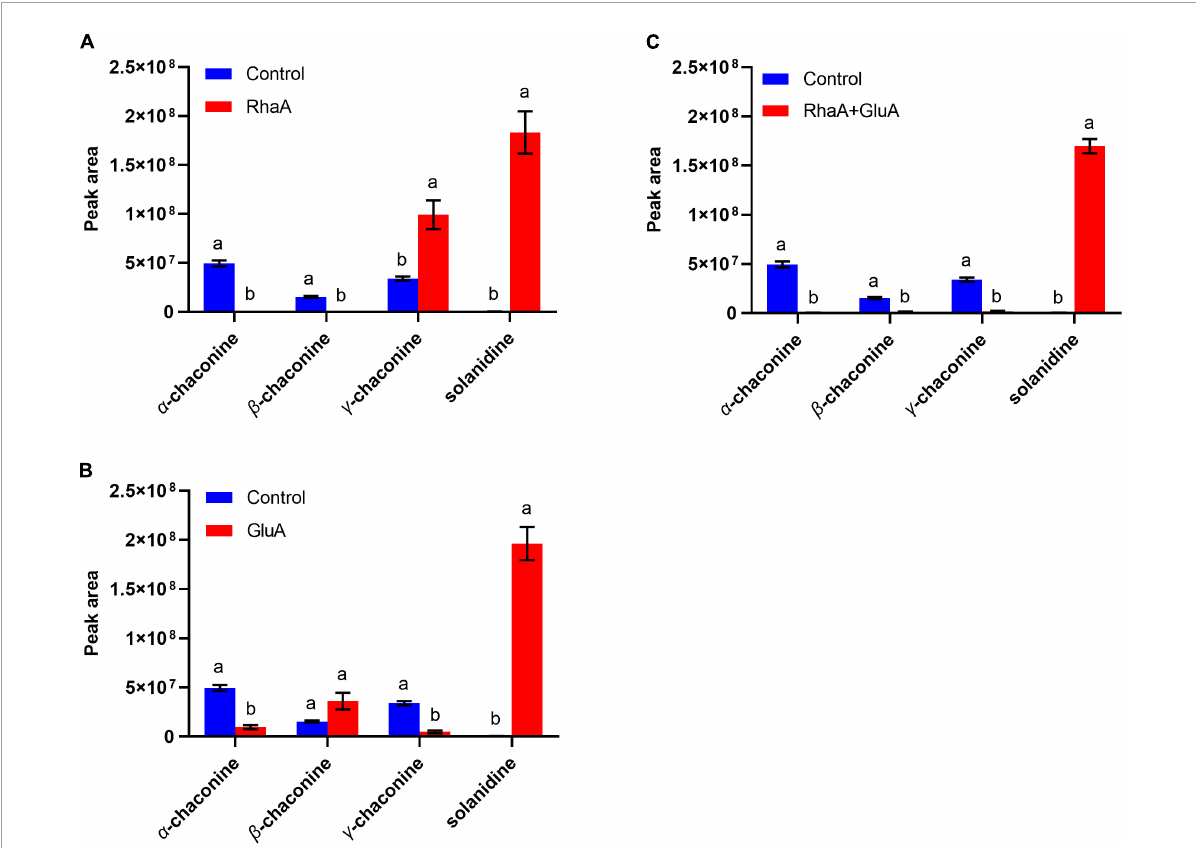
FIGURE4 Hydrolysis products released from α -chaconine standards by the action of recombinant enzymes of (A) RhaA; (B) GluA; (C) RhaA + GluA. Bars (mean ± SD) labeled with different letters within each treatment are significantly different ( P < 0.05, independent-sample t -tests, n = 3).